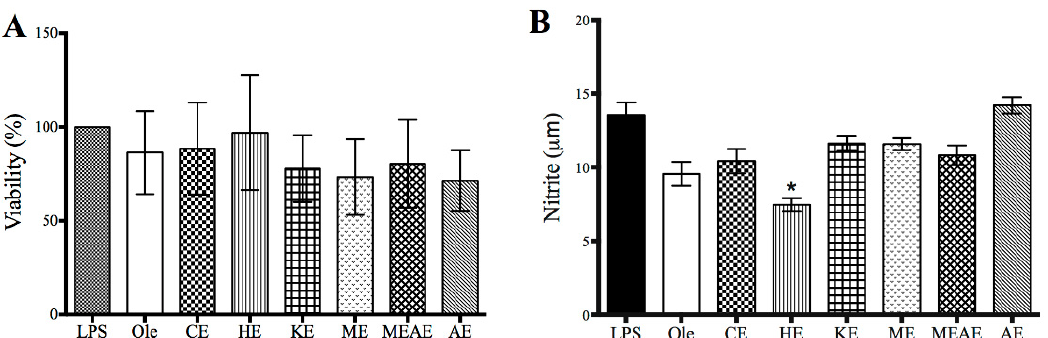
Figure 9. ( A ) Viability of RAW 264.7 cells treated with of lipopolysaccharides (LPS) of E. coli (1 μ g/mL), oleanolic acid or different extracts (25 μ g/mL) from Acacia farnesiana pods. ( B ) Nitrite concentration in supernatants of RAW 264.7 cells treated with LPS of E. coli (1 μ g/mL), oleanolic acid (Ole) different extracts (25 μ g/mL) from Acacia farnesiana (AF) pods. CE = chloroformic extract; HE = hexanic extract; KE = ketonic extract; ME = methanolic extract; MEAE = methanolic:aqueous extract and AE = aqueous extract. Each bar represents mean ± standard deviation ( n = 6). * p < 0.05 between extracts respect to LPS.